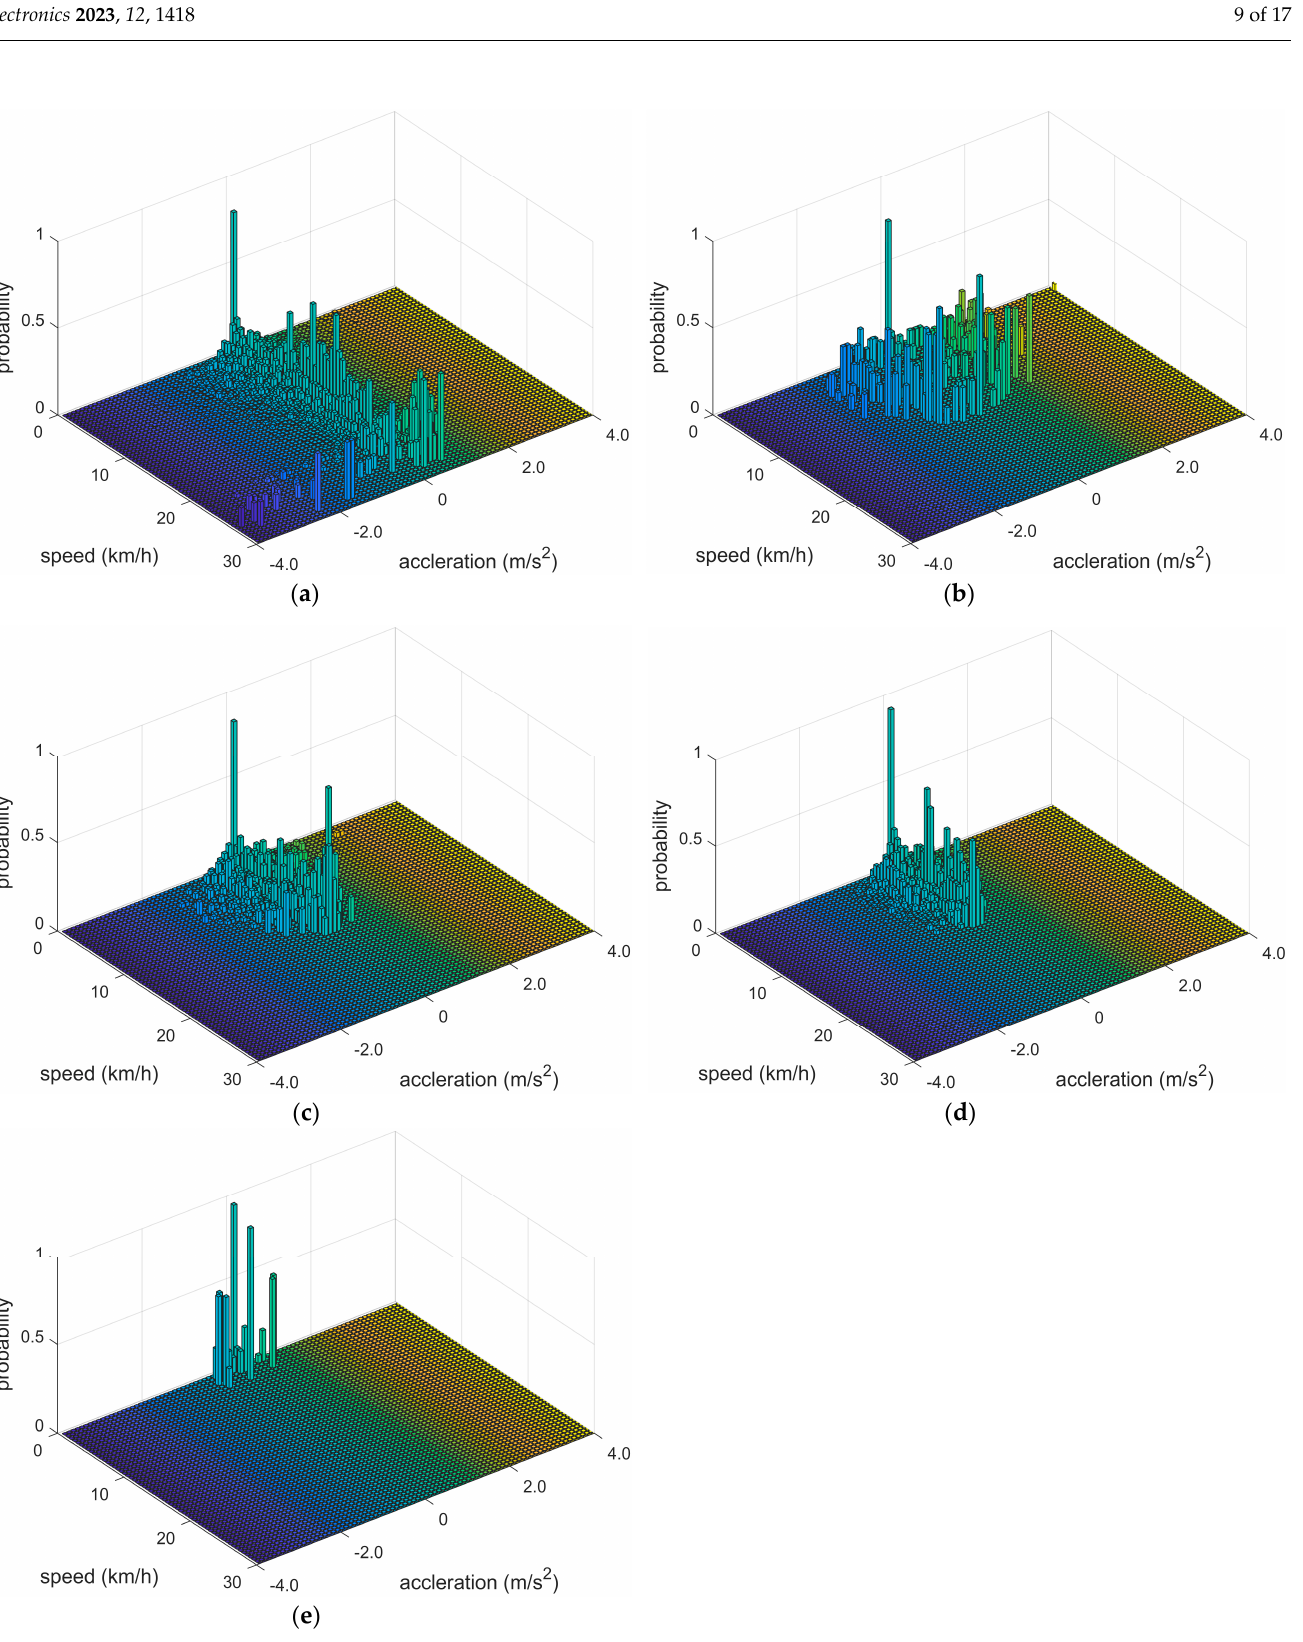
8 of 17 Figure 6. Classi fi cation results of the K-means algorithm. For each classi fi cation, the principle of Markov chain model is utilized to predict the future speed of the HEV. To predict the future speed of the vehicle, it is necessary to cal- culate the transition probability between states, that is, the state transition probability ma- trix. The speci fi c calculation process is as shown in (2) [27]. Results obtained are shown in Figure 7.